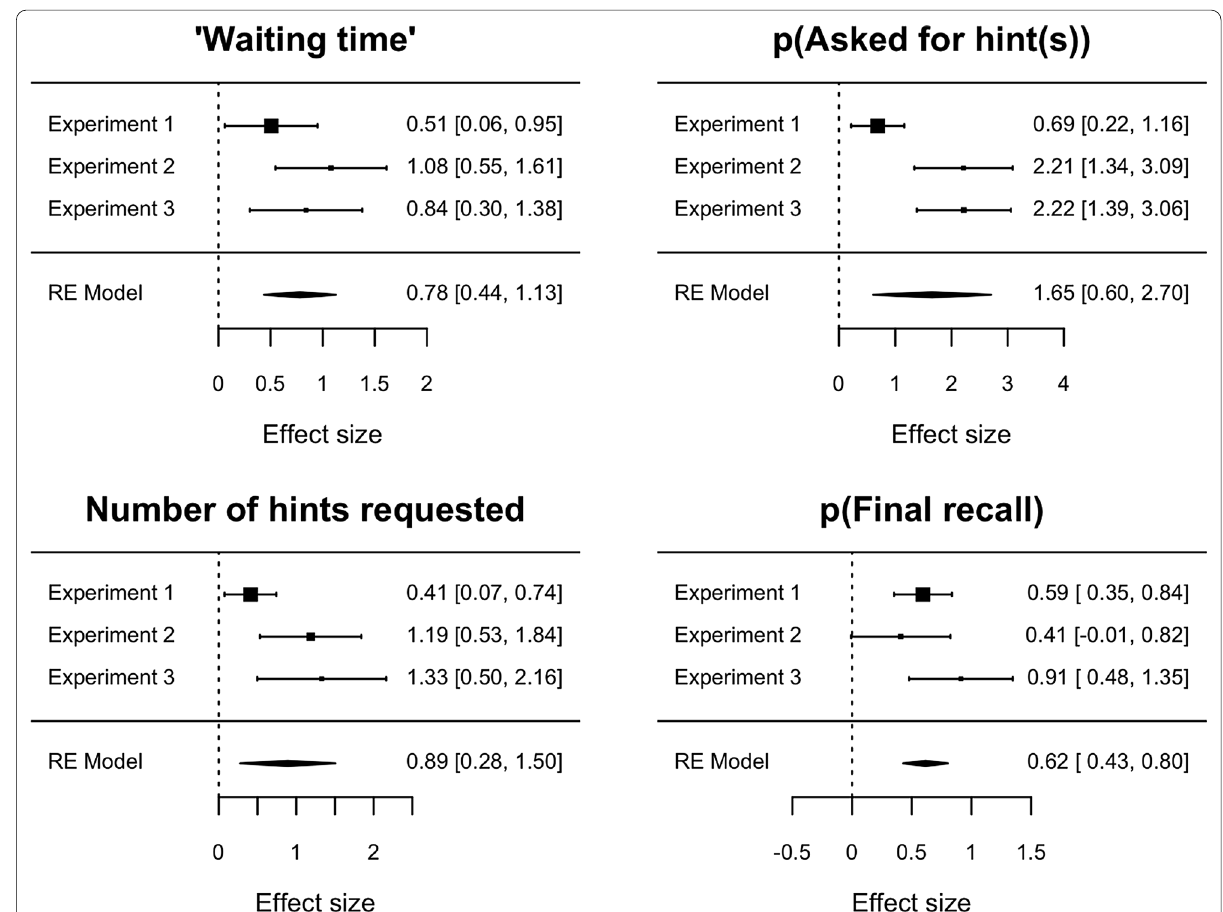
Fig. 4 Forest plots of meta‑analytic results. Note. Points and intervals indicate effects and 95%CIs (duplicated in text in the right columns). Curiosity was median‑split by participant in Experiment 1 to make the estimates comparable to Experiments 2 and 3 that used binary